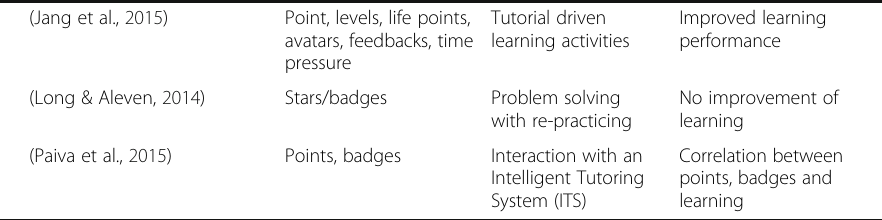
Note. The first column (Cat) contains the categories, while the second column contains the papers reporting the corresponding outcomes. The question mark ” ? ” placed after a statement in the outcomes column marks the corresponding results as